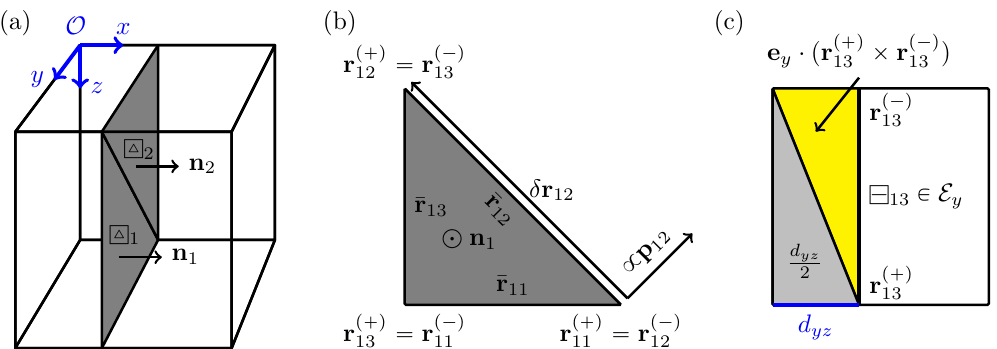
( a ) Illustration of a simple triangulated surface S with normal n “ e in L x the unit cube Ω . Note that this example serves only to illustrate the definitions used in L Section 3.1; it is not periodic. A Bragg mirror ( cf. Section 5.1) is defined by two anti-parallel planes. ( b ) o as seen from region Ω p 0 q with edge centres ¯ r , end points r p˘q , the exemplary 1 1 η 1 η L end-to-end vectors δ r and the perpendicular vector (not to scale) p . ( c ) Front facet of the 12 12 unit cube in ( a ). The surface integral over B Ω splits up into the yellow part that is calculated y via the edge a corresponding to the second sum in Equation (13) and the light gray P E 13 y part that is calculated with the length d of the part of the edge y “ z “ 1 that is part of yz . The area parts shown here contribute to the volume integral as triangular base faces of B Ω j pyramids. The volume of the internal pyramids with base faces o and o , respectively, is 1 2 calculated in the first sum in Equation